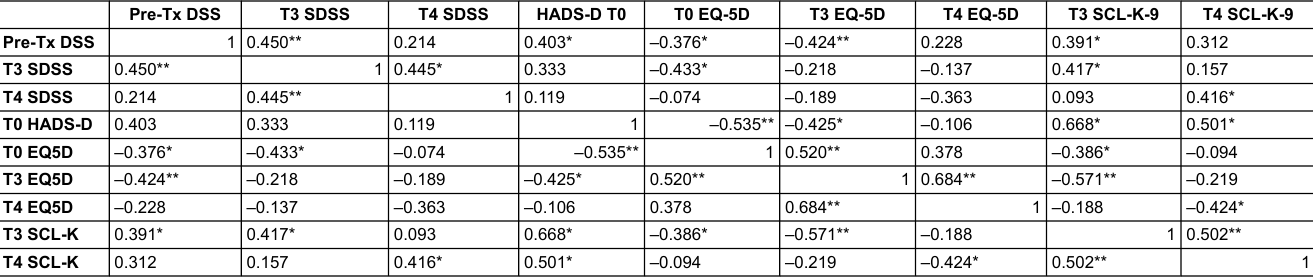
Table 3: Bivariate correlations between pre-transplant disease severity score, somatic disease severity score and mental health outcomes. Pre-Tx